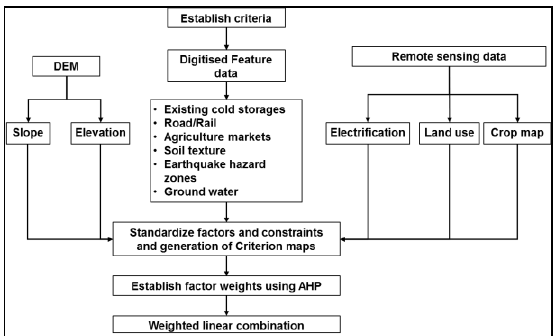
Figure 2. Methodology followed for developing